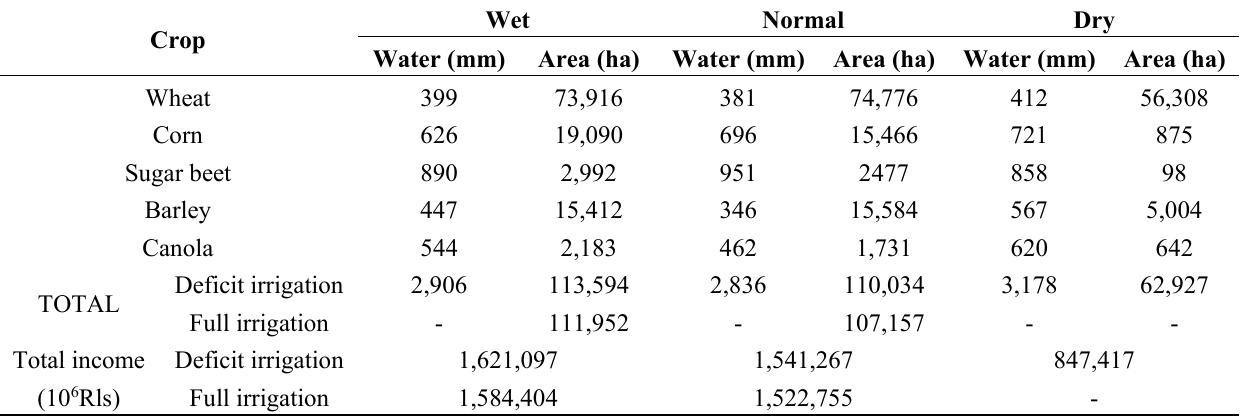
Table 4. Optimum water allocation from reservoir, optimum cultivation area of different crops and total income under various weather